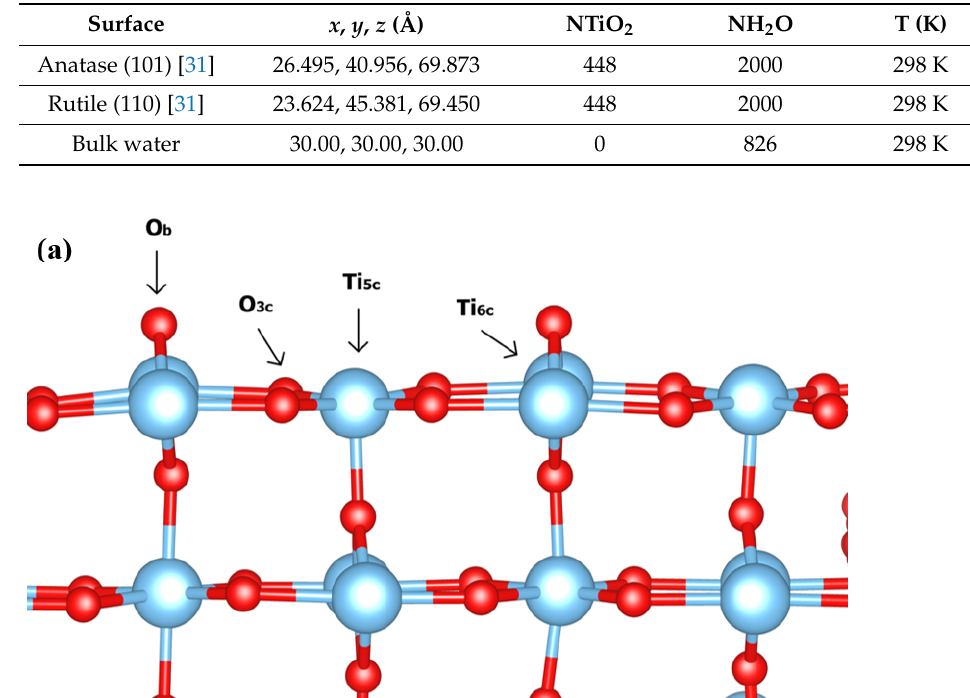
Table 1. Details of the systems used in this work.